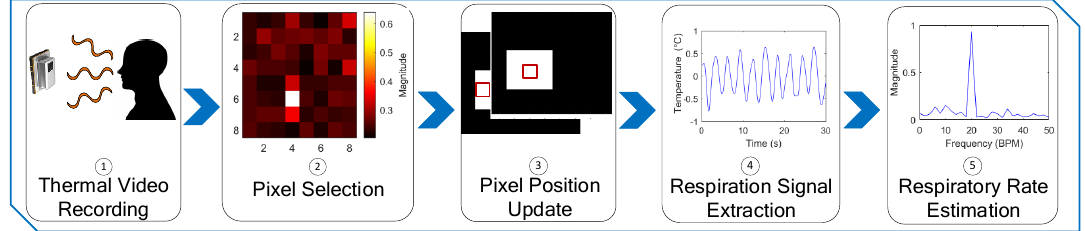
Figure 1. Block diagram summarizing the processing chain from images’ acquisition to respiration rate